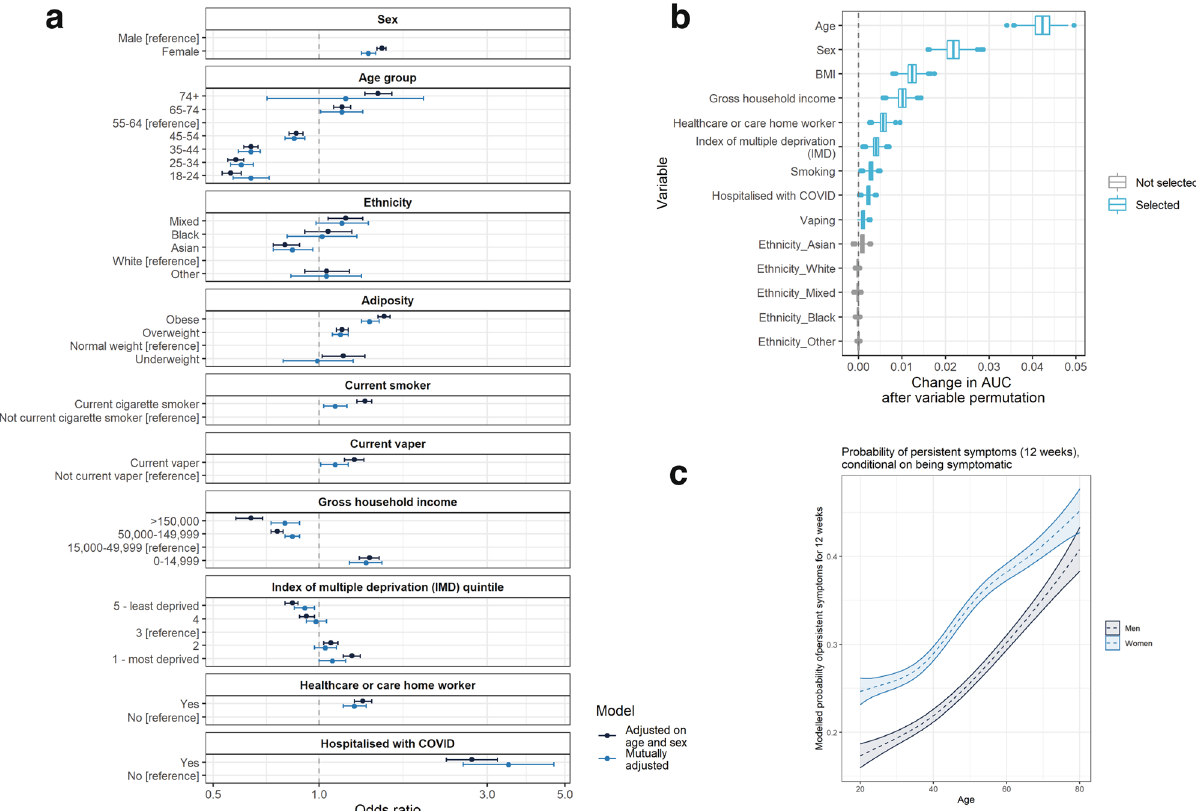
Fig. 4 Modelling of persistent symptoms as a function of biological and demographic variables. a Logistic regression models with one or more symptoms at 12 weeks (y/n) as the binary outcome variable, both adjusted for age-sex and mutually adjusted*; b mean contribution to area under the curve (AUC) that each variable makes to a multivariable boosted tree model, derived by permuting each variable in turn (1000× to obtain a distribution) and quantifying the change in model performance; c modelled probability of persistent symptoms at 12 weeks as a function of age and sex, using generalised additive models with splines on age and interactions between age and sex. All models were fi t on n = 71,642 respondents for whom we had 150 days ’ observation time. Age, sex, adiposity household income, healthcare/care home worker, deprivation, current smoker status and prior hospitalisation with COVID-19 are the strongest predictors of persistent symptoms in multivariable modelling, while Asian ethnicity is associated with a lower risk of persistent symptoms at 12 weeks. Box plots in panel b show median, fi rst and third quartiles; whiskers indicate 1.5 × the interquartile range; data beyond this range are plotted as points. Note: Owing to missing data in some variables, the total n for the mutually adjusted model in panel a is